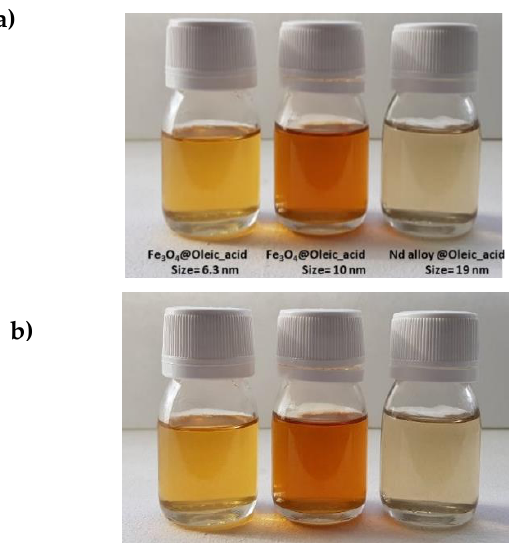
Figure 6. Visual observation of the stability of the nanolubricants TMPTO + 0.015 wt% NP: a ) just after sonication of 240 min; b ) 11 months after sonication.